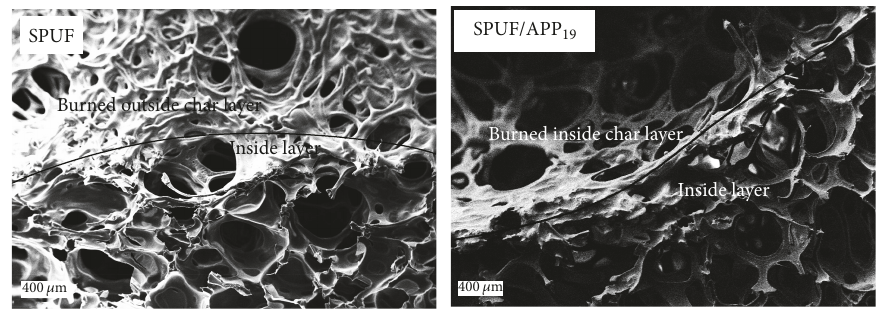
Figure 5: SEM images of residual char.